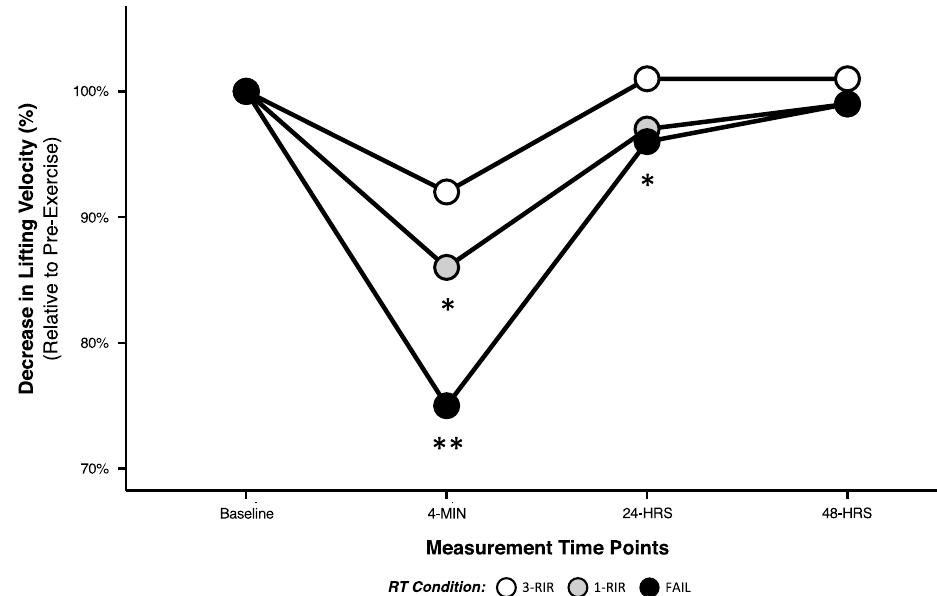
Fig. 3 Post-exercise recovery time course of neuromuscular fatigue for all participants (males and females combined). Changes in lifting velocity are expressed as percentage values relative to pre-exercise. Data shown are presented as mean values (accompanying SD values can be found in Table 3). *Denotes a statistically significant difference from 3-RIR. **Denotes a statistically significant difference from 1-RIR and